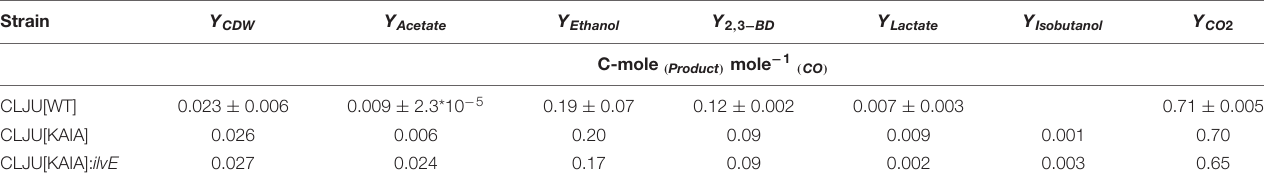
Values of the wildtype cultivation indicate mean of